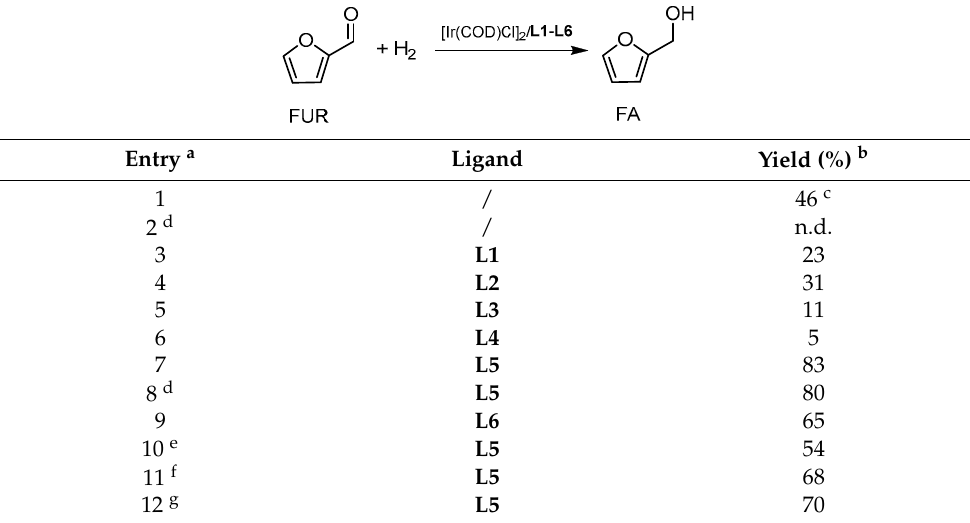
Table 1. Ligands and solvents screened for the hydrogenation of FUR to FA.